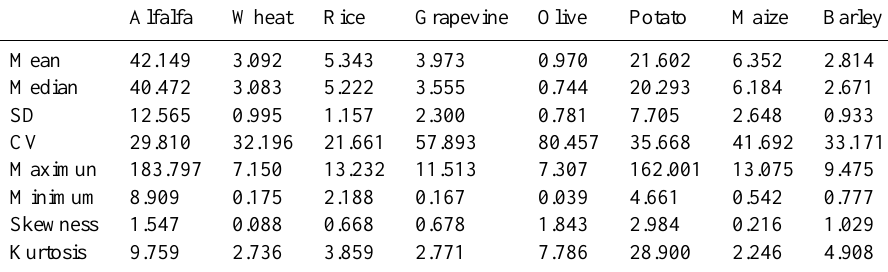
Table 7. Statistical properties of yield simulations. Alfalfa Wheat Rice Olive Potato Maize Barley